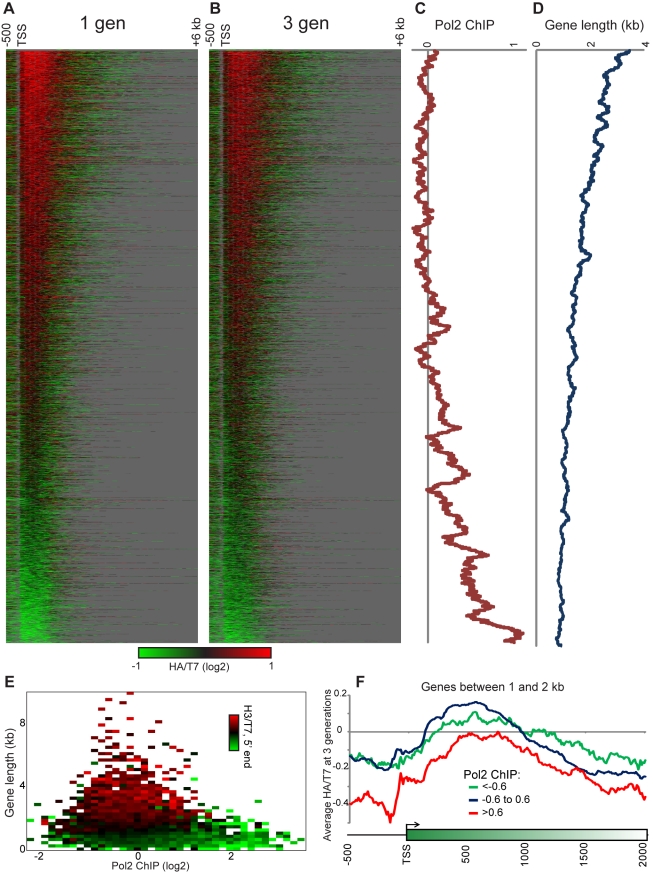
Ancestral H3 molecules accumulate at the 5′ ends of long,
poorly transcribed genes.(A–B) Heatmap of sites of ancestral H3 accumulation. Genes are
aligned by TSS (indicated), and Log2 HA/T7 ratios are
indicated as a heatmap. Genes are ordered by the median HA/T7 ratio over
the 5′-most 1 kb at 3 generations. Grey over coding regions
indicates missing data; grey downstream of genes indicates sequence
downstream of the 3′ end of the gene to show gene length.
Accumulation of ancestral histones at the 5′ ends of genes peaks
around the +3 nucleosome, as expected given that the +1 and
+2 nucleosomes are generally subject to high rates of
replication-independent H3/H4 replacement [15],[17]. (C) An 80 gene
sliding window average of Pol2 ChIP levels [75] for genes ordered as
in (A–B), showing that genes with low levels of ancestral H3
retention are highly transcribed. (D) 80 gene sliding window average of
gene lengths, showing that genes with high levels of ancestral H3
retention tend to be long. (E) The median HA/T7 ratio over the 5′
end of genes (1 kb) was calculated for all genes, and median values of
this retention metric are shown for groups of genes ordered by
transcription rate (x-axis) and gene length
(y-axis). While these are not
independent—highly expressed genes tend to be short—for a
given gene length genes transcribed at higher levels exhibit low HA
retention levels. This is true mostly of genes shorter than 3 kb, which
encompasses the majority of yeast genes. (F) Average HA/T7 ratios (Log2)
for genes between 1 and 2 kb, broken into high (red), low (green), and
intermediate (blue) transcription rates.